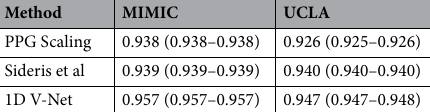
Table 3. Correlation (mean (95% CI)) between true and predicted blood pressure for each cohort.